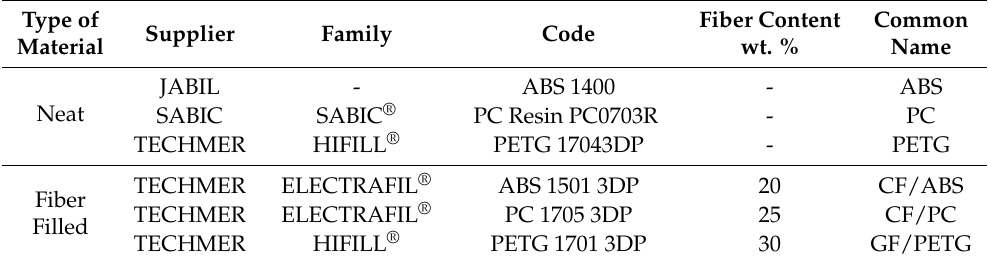
Table 1. Material technical information.